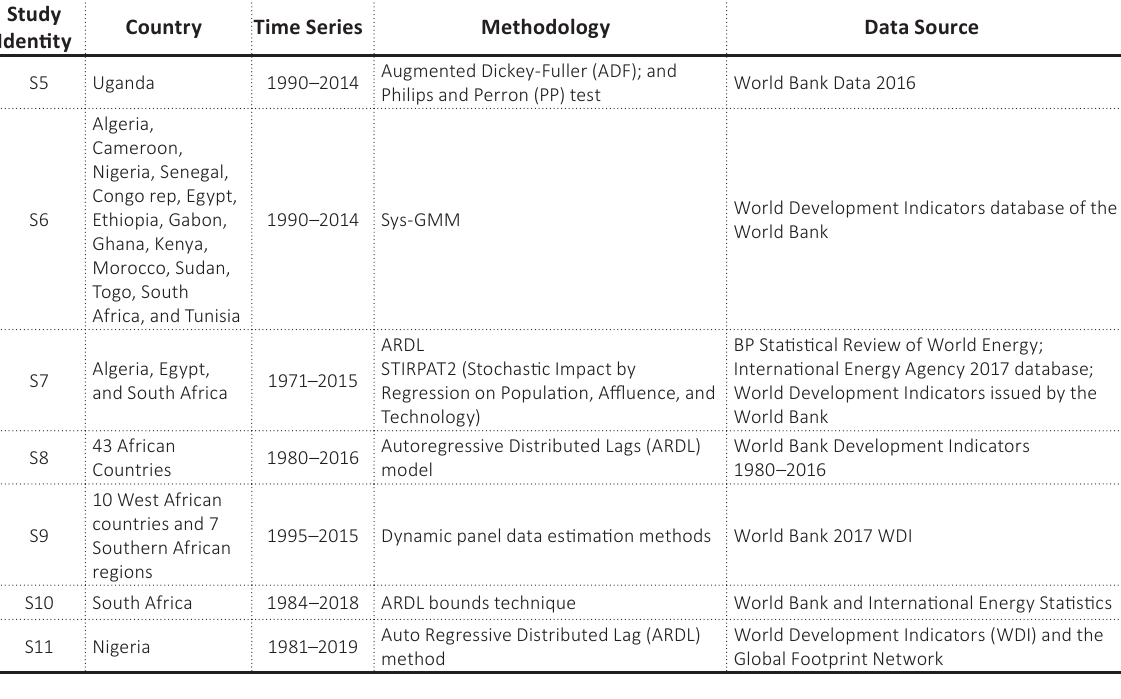
Table 3. Impacting factors on carbon emissions in Africa